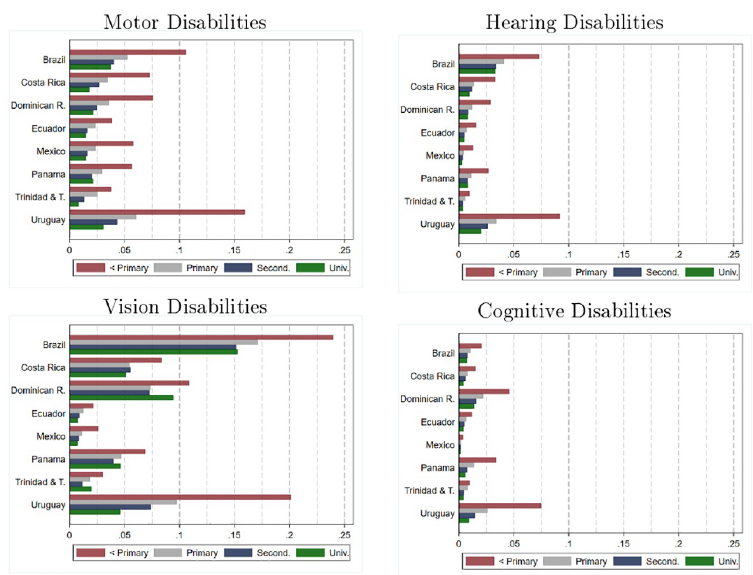
Fig 6. Prevalence of disability: Estimates by type, country and household head education level. Source: authors’ estimations based on data provided by [10] from censuses collected by National Statistics Offices in each country. Estimates for Brazil, Dominican Republic, Ecuador, Mexico, and Panama refer to the year 2010. Estimates for Costa Rica, Trinidad and Tobago, and Uruguay refer to the year 2011. Estimates consider individuals aged 3 years and older.